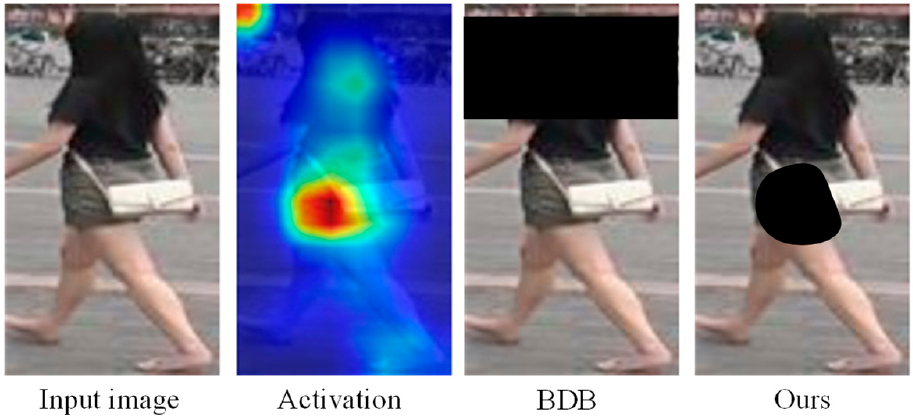
Figure 2. BDB creates a random block mask, while the proposed method creates an unshaped mask based on the most active part of the